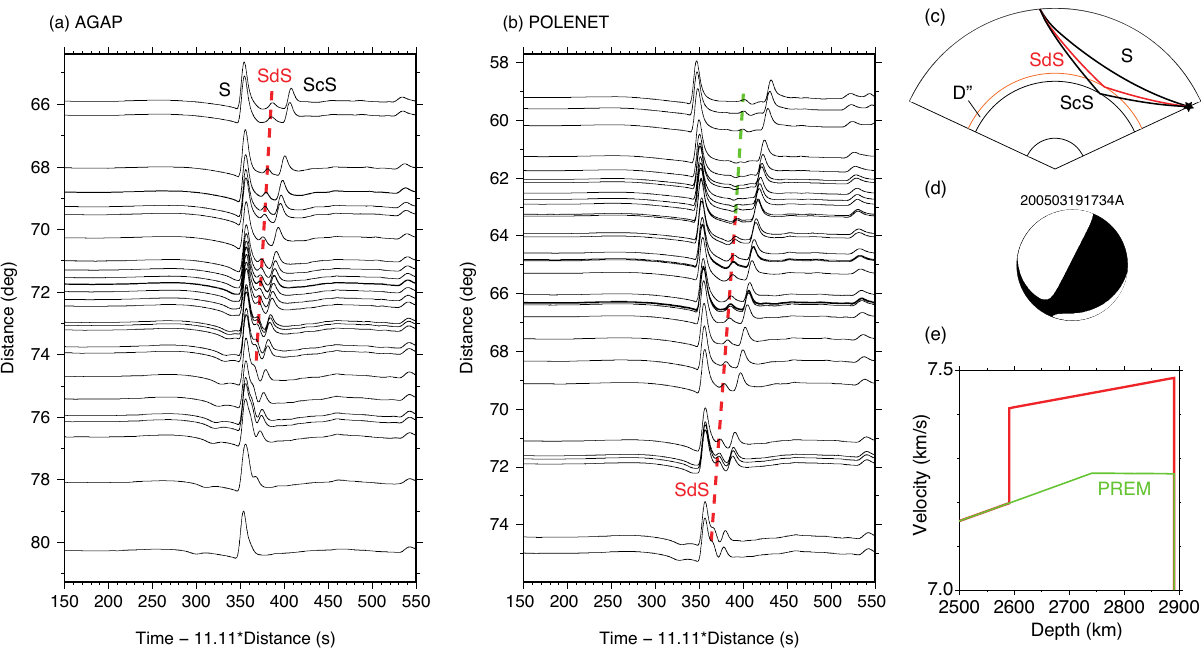
Figure 5. Seismograms of the SH component synthesized by reflectivity method for a typical deep Fiji event to the (a) AGAP and (b) POLENET stations. Clear arrivals of SdS are marked with a red broken line in (a) and (b). Predicted arrival of SdS with no clear and coher- ent signal is marked by a green line in (b). The reduced velocity of 11.11°/s is adopted to emphasize S, SdS and ScS phases. (c) Ray paths of S, SdS and ScS on a vertical cross-section. (d) A focal mechanism solution of a typical deep Fiji event (the CMT solution of the event 2005/03/19) that is used in the calculation. (e) A red line is a velocity profile in D" region that is used in the calculation. PREM [Dziewon- ski and Anderson 1981] is drawn by a green line for